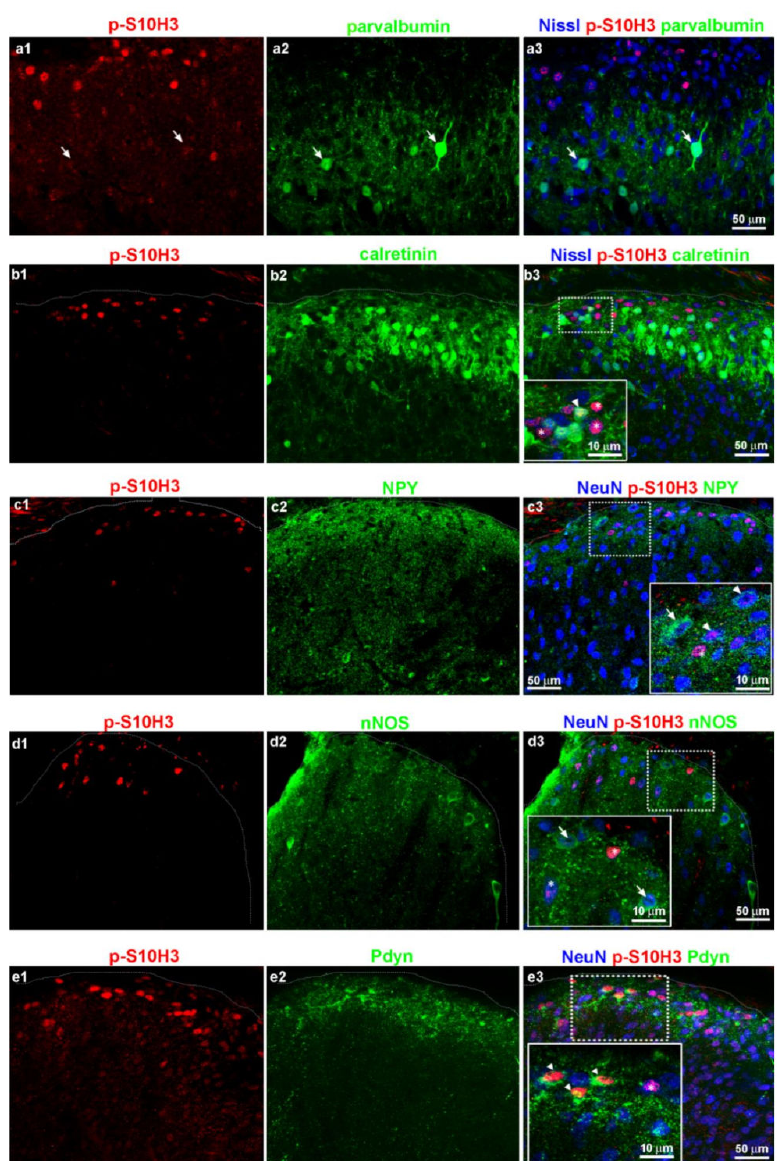
Figure 7. Burn injury-induced S10H3 phosphorylation in inhibitory subpopulations of SDH neurons. ( a1 – a3 ) A representa- tive image showing immunostaining for p-S10H3 (red; a1 , a3 ), Nissl dye (blue; a3 ) and parvalbumin (green; a2 – a3 ). Nearly all p-S10H3-positive nuclei fell outside the band rich in parvalbumin-immunoreactive profiles and none was present in parvalbumin positive somata of deeper laminae (arrows). ( b1 – b3 ) Immunostaining for p-S10H3 (red; b1 , b3 ), Nissl dye (blue; b3 ) and calretinin (green; b2 , b3 ). Calretinin positive neurons occasionally contained p-S10H3-positive nuclei (arrowhead in the inset). Asterisks indicate p-S10H3-IR neurons without calretinin immunolabeling. ( c1 – c3 ) Immunostaining for p-S10H3 (red; c1 , c3 ), neuronal marker, NeuN (blue; c3 ) and NPY (green; c2 , c3 ). Hardly any of the rare NPY-IR neuronal somata contained a p-S10H3-positive nucleus as indicated with arrowheads. Asterisk marks p-S10H3-IR neurons without NPY immunolabeling. Arrow marks an NPY+ interneuron that lacks p-S10H3. ( d1 – d3 ) Immunostaining with antibodies against p-S10H3 (red; d1 , d3 ), NeuN (blue; d3 ) and nNOS (green; d2 , d3 ). Asterisk indicates a p-S10H3-IR neuron without nNOS immunolabeling. Arrows show nNOS-IR neurons in which p-S10H3 was not upregulated upon burn injury. ( e1 – e3 ) Immunostaining with antibodies against p-S10H3 (red; e1 , e3 ), NeuN (blue; e3 ) and prodynorphin (Pdyn) (green; e2 , e3 ). Several p-S10H3-immunostained nuclei were localized within dynorphin-positive somata (arrowheads in the inset). In the higher magnification image, an asterisk labels a non-dynorphinergic neuron that exhibits p-S10H3. Dotted lines indicate the border between gray and white matter ( b3,c3,d3,e3